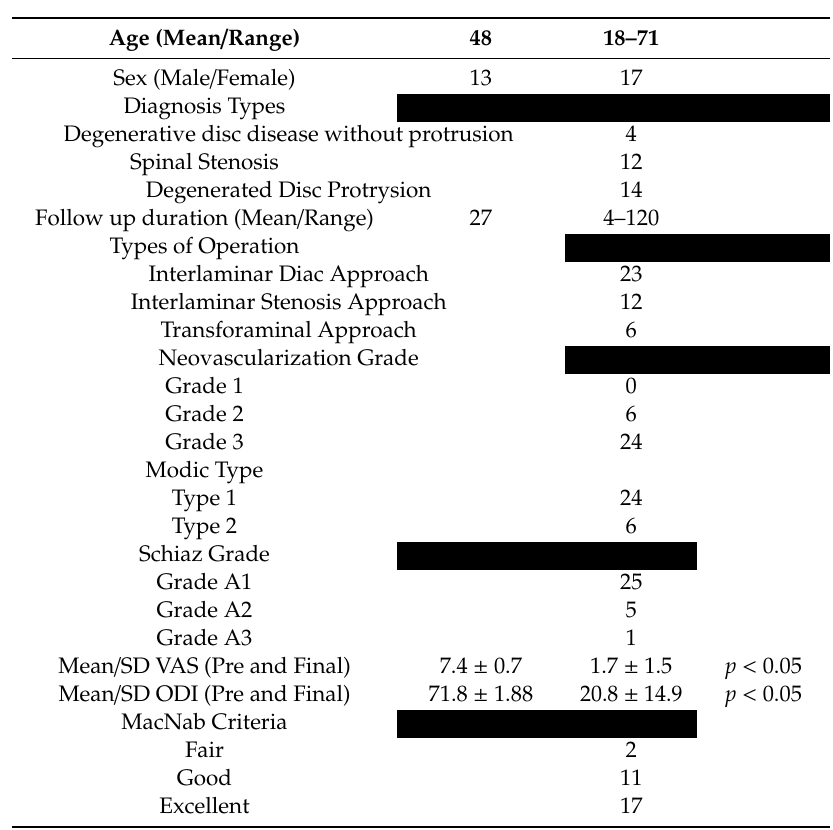
Figure 1. Mean Visual Analogue Scale Pre-operative, 1 week, 6 months post-operatively and Oswestry Disability Index at 1 week, 6 months post-operatively and final follow up showing clinically significant decrease in disability. Table 1. Background data and results of Patients who underwent Sinuvertebral Nerve and Basivertebral Nerve Radiofrequency